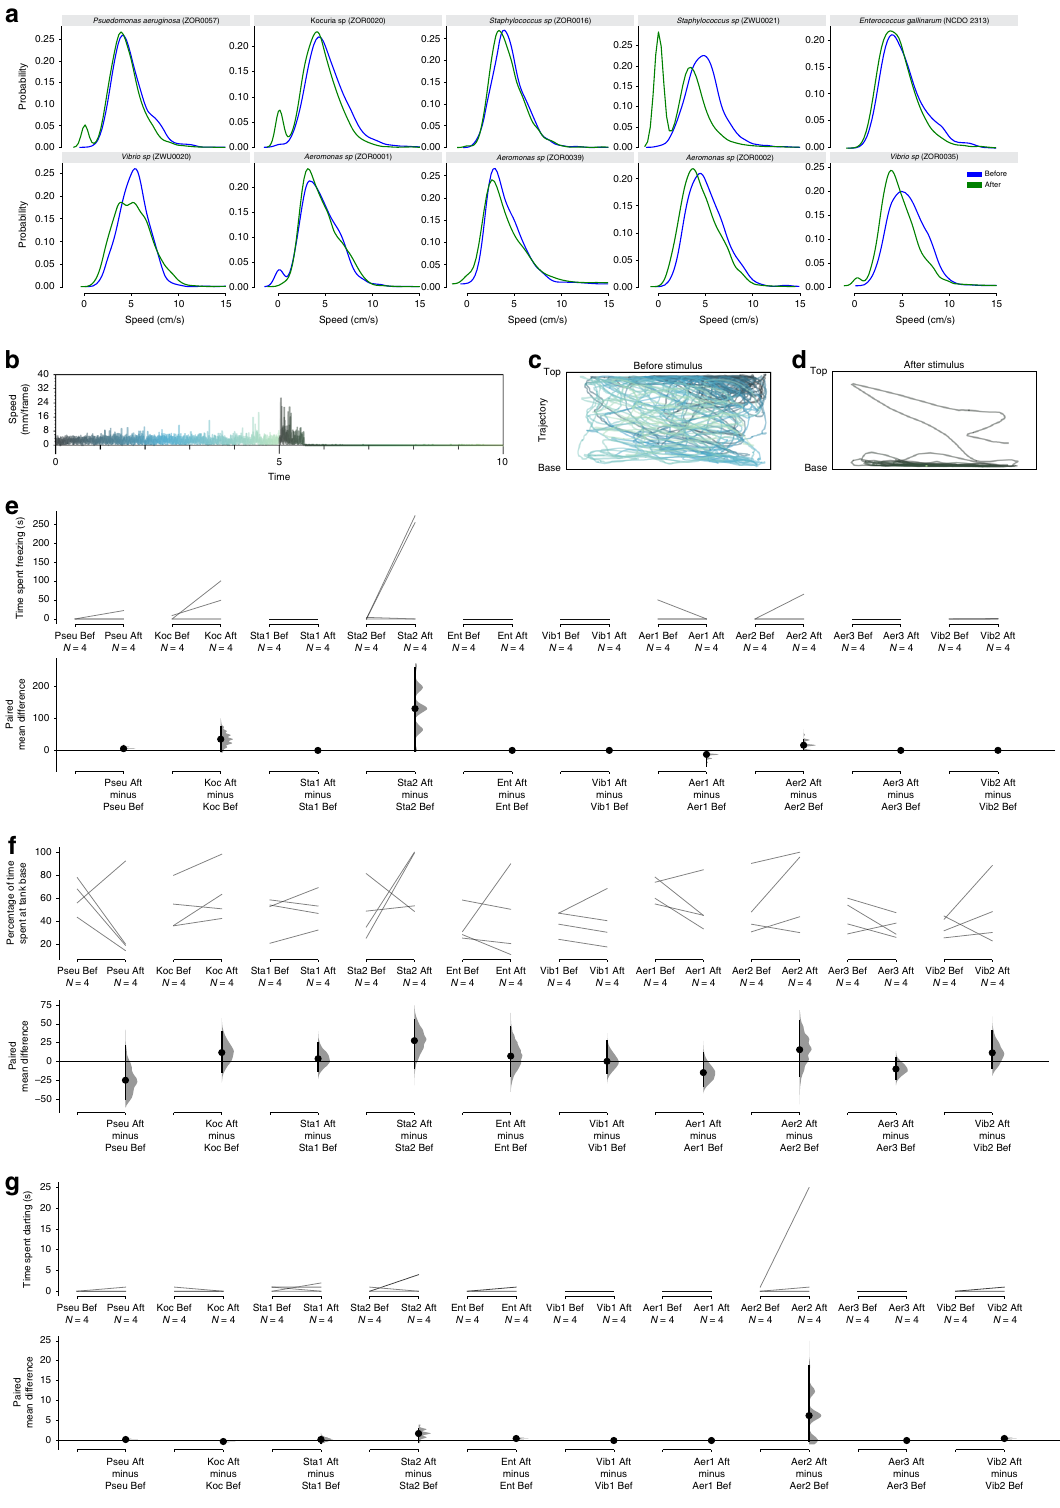
Fig. 4 Effect of commensal bacteria on zebra fi sh behavior. a Effect of lysates from ten different cultured bacteria on behavior of adult zebra fi sh, as indicated by probablity density function of speed before (blue) and after (green) application of the lysate. b – d Response of one fi sh to lysate from the bacteria Staphylococcus sp . ZWU0021. b Speed of the fi sh. The trace is color coded according to time, with dark gray indicating the delivery of the lysate. Position of the fi sh, before ( c ) and after ( d ) stimulus. Effect of bacterial lysate of adult fi sh, as indicated by time spent freezing ( e ), percentage of time at tank base ( f ), and time spent darting ( g ), as shown by Cumming estimation plots 72 . The raw data are plotted on the upper axes and each paired set of observations (before (Bef) and after (Aft) delivery of bacterial lysate) is connected by a line. On the lower axes, each paired mean difference is plotted as a bootstrap sampling distribution. Mean differences are depicted as dots; 95% con fi dence intervals are indicated by the ends of the vertical error